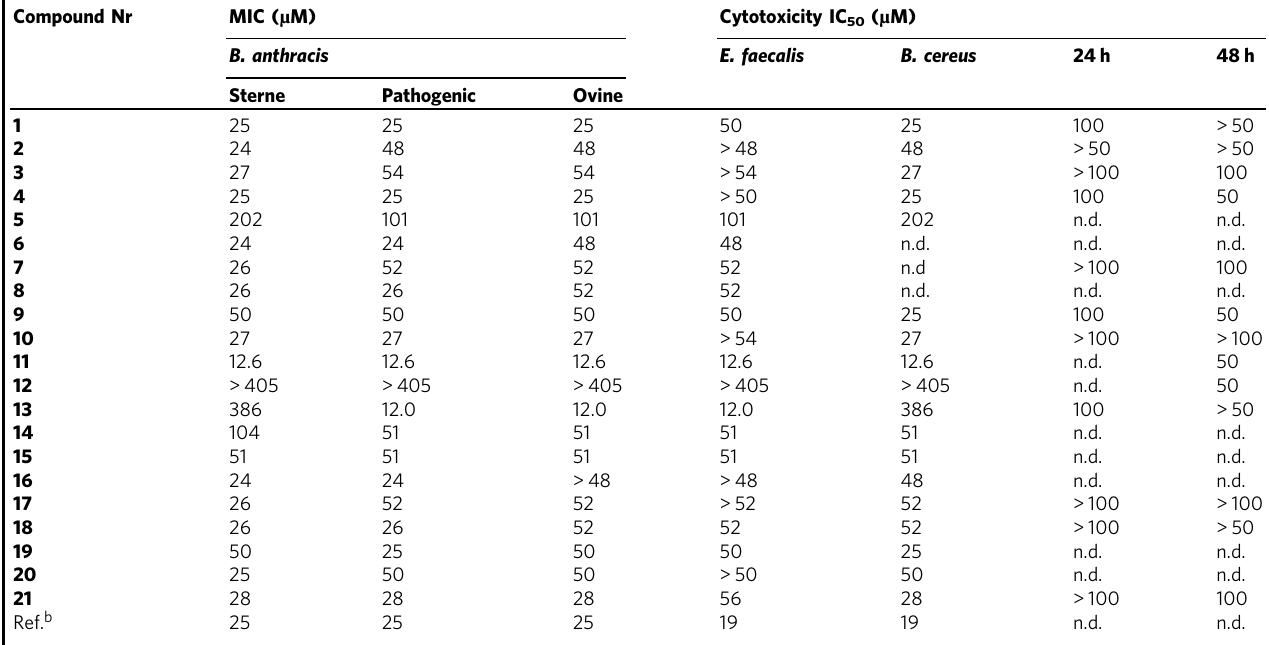
Table 1 Antibacterial activity a expressed in MICs and cytotoxicity over Caco-2 cells expressed in IC 50 (MTT assay) Compound